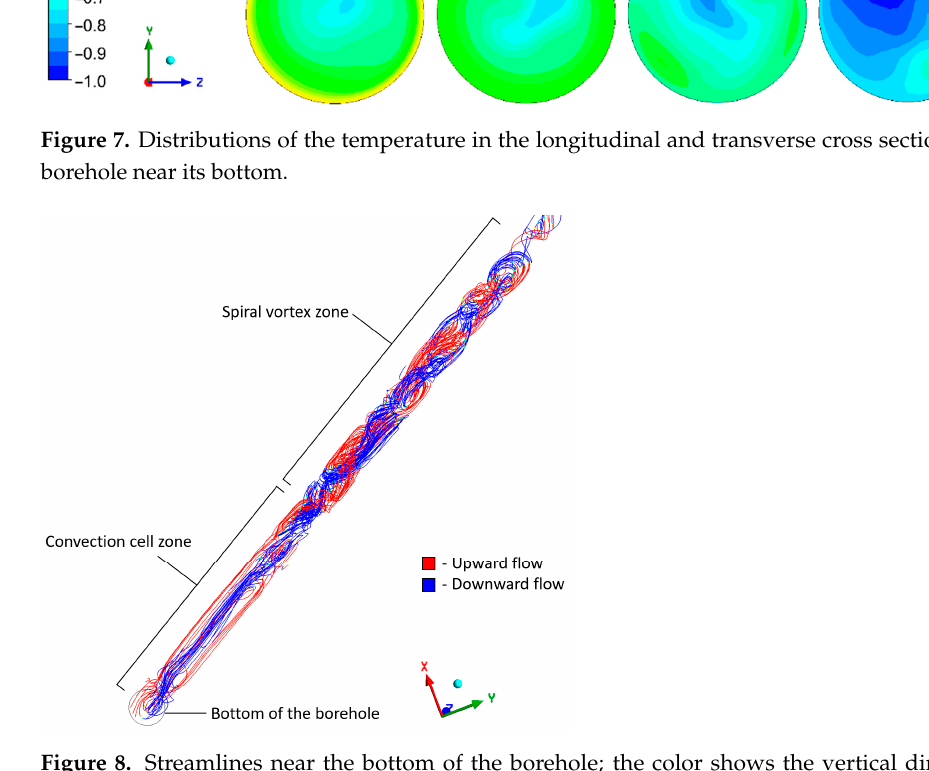
Figure 8. Streamlines near the bottom of the borehole; the color shows the vertical direction of the flow. the